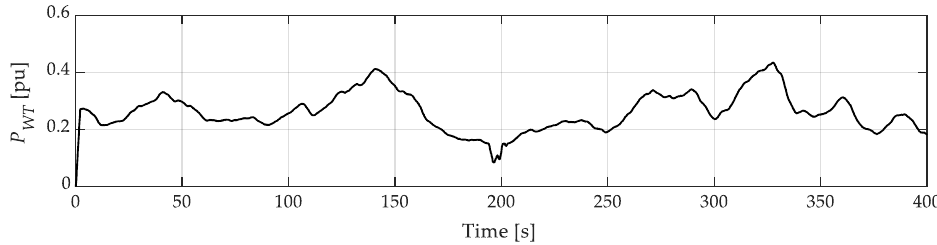
Figure 15. Emulated wind generation in the laboratory.